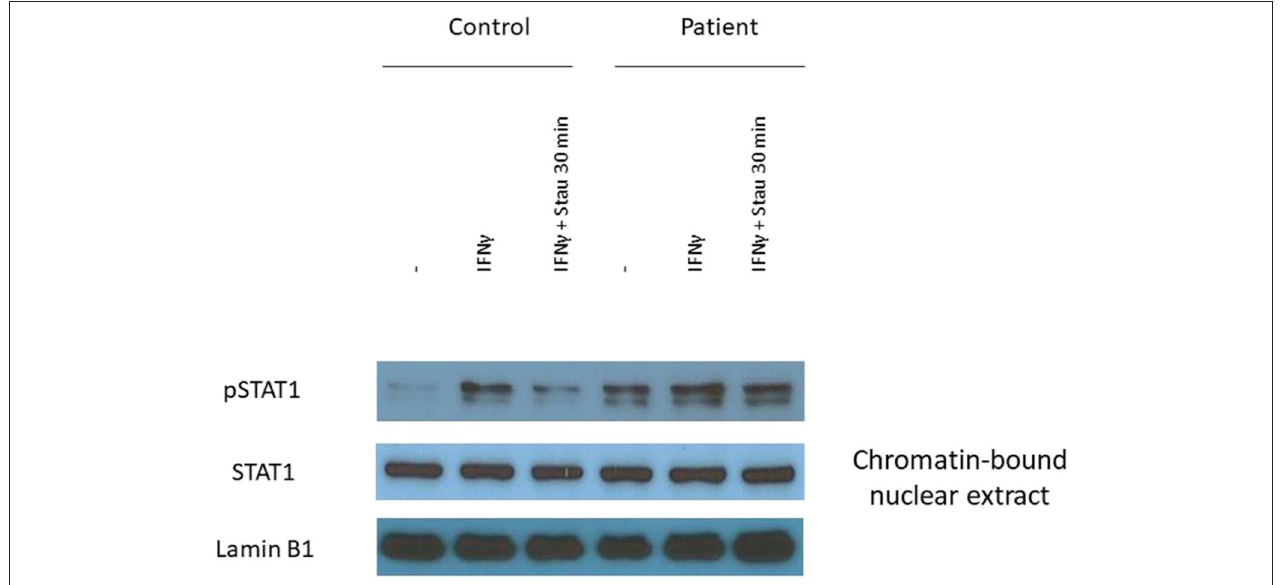
FIGURE 3 | The L407V amino acid change in STAT1 results in gain-of-phosphorylation. The expression of pSTAT1 and STAT1 were assessed by immunoblot. EBV-B lymphocytes were stimulated with IFN- γ for 30min. To determine the inhibition of dephosphorylation we added tyrosine inhibitor staurosporine into the cell suspension for 30min.